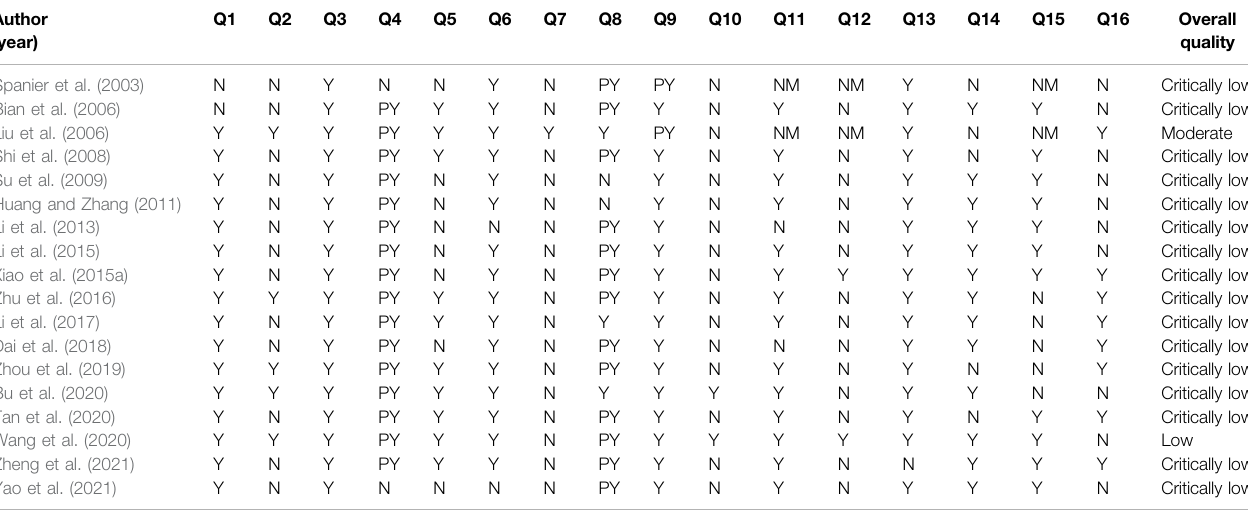
TABLE 3 | Methodological quality assessment of the included reviews using the AMSTAR 2